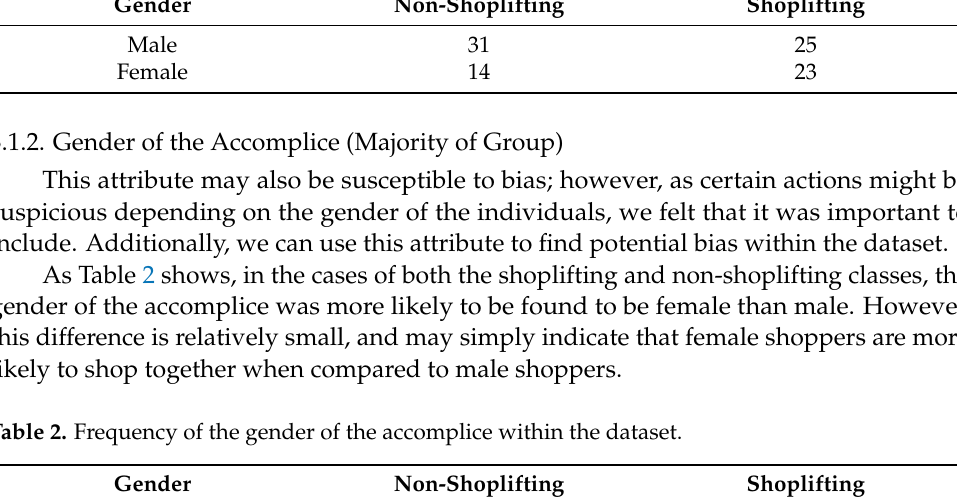
Table 2. Frequency of the gender of the accomplice within the dataset. Gender Non-Shoplifting Shoplifting